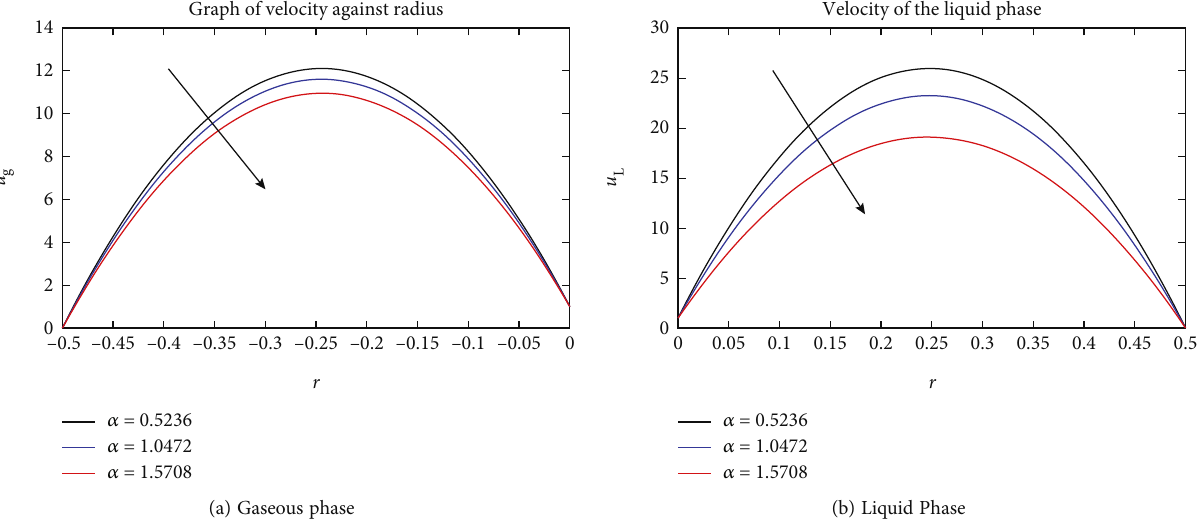
Figure 5: E ff ects of Angle of Inclination α on